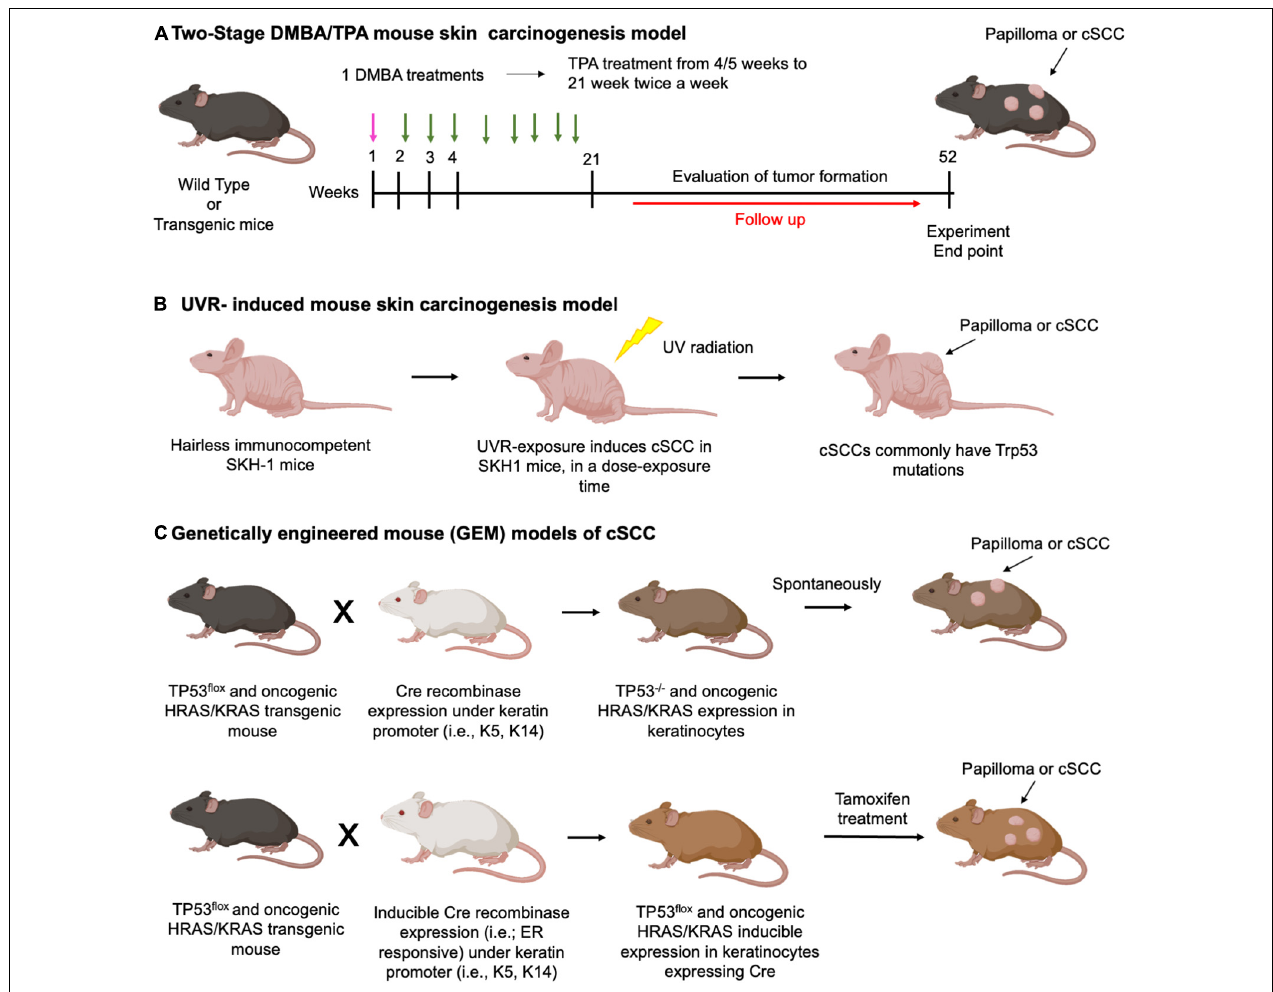
FIGURE 5 | Carcinogen-induced models of cSCC. Schematic representation of the protocols used for (A) Two-stage DMBA/TPA mouse skin carcinogenesis model. DMBA treatment (pink arrows), TPA treatment (green arrows). Typically, a single DMBA treatment (week 1) is followed by sustained TPA treatments up to 20 weeks. From 21 to 52 weeks a follow up of the animals will evaluate tumor formation; (B) UVR-induced mouse skin carcinogenesis model: hairless immunocompetent SKH-1 mice undergo UVR exposure, which typically induces Trp53 mutation. cSCC formation depends on dose and time of exposure. (C) Example of genetically engineered mouse (GEM) models of cSCC. Upper panel: p53 Flox mice and oncogenic HRAS or KRAS expressing mice are mated with transgenic conditional keratinocyte Cre recombinase expressing mice. Cre expression is constitutive under control of a keratin promoter. The offspring with loss of p53 or oncogenic HRAS and KRAS expression spontaneously develop papilloma or cSCC.; lower panel: mating scheme and tumor formation works as described for the upper panel. However, Cre protein is fused with the estrogen receptor (ER), generating a CreERT protein that works only after tamoxifen